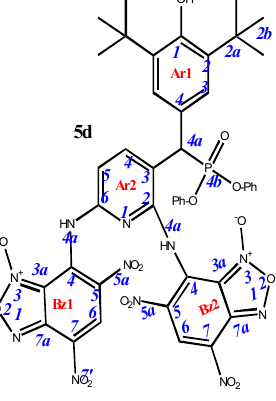
7,7’- (( 3- (( 3,5-di- tert -butyl-4-hydroxyphenyl )( diphenoxyphosphoryl ) methyl ) pyridine-2,6-diyl ) bis ( azanediyl )) bis ( 4,6-dinitrobenzo[ c ][1,2,5]oxadiazole 1-oxide ) ( 5d ) . Brick red powder, yield 75%. M.p.: >250 ° С . IR ( ν , cm –1 ): 695 (P–C), 1209 (P=O), 1378 (NO 2 symm), 1569 (NO 2 asymm), 1622 (furoxan ring) and 3444 (OH). 1 H NMR (400 MHz, DMSO- d 6 ) δ 8.87 (s, 1H), 8.67 (s, 1H), 8.34 (d, J = 8.4 Hz, 1H), 8.28 (s, 1H), 7.30 (d, J = 8.1 Hz, 2H), 7.17 (m, 5H), 7.07 (m, 1H), 6.99 (d, J = 8.3 Hz, 2H), 6.87 (br.s, 1H), 6.64 (d, J = 8.2 Hz, 2H), 5.26 (m, 1H) and 1.24 (s, 18H). 13 C NMR (126 MHz, DMSO- d 6 ) δ 162.8, 161.7, 153.8, 150.4, 148.4, 147.7, 139.6, 135.2, 134.6, 130.4, 130.2, 130.2, 130.1, 129.9, 129.8, 127.6, 126.6, 125.6, 125.3, 120.9, 120.8, 120.4, 115.1, 111.9, 111.4, 36.2, 34.9 and 30.5. 31 P NMR (162 MHz, DMSO-d 6 ) δ 18.80. Found: %: C, 52.49; H, 3.77; N, 15.35; P, 3.01. Anal. calcd (%) for C 44 H 38 N 11 O 16 P: C, 52.44; H, 3.80; N, 15.29; P, 3.07.